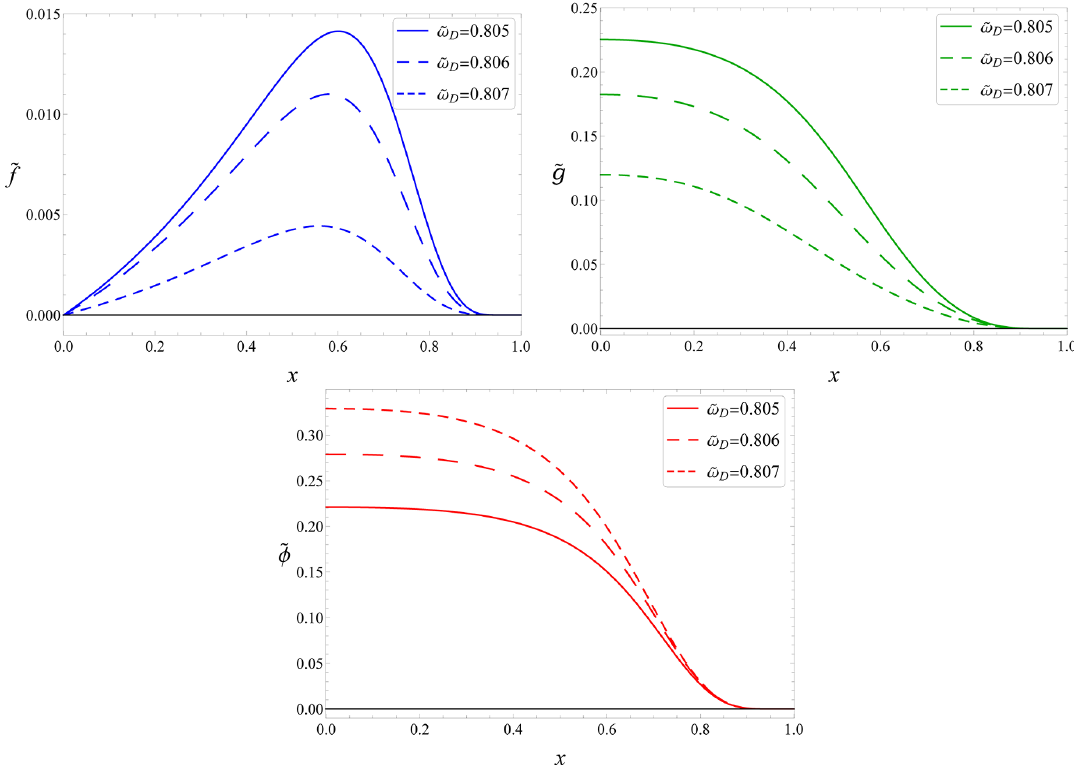
Figure 5. Dirac field functions ˜ f and ˜ g (top panels) and Scalar field function ˜ φ (bottom panel) as functions of x with ˜ ω D = 0 . 805 , 0 . 806 , 0 . 807 . All solutions have ˜ ω S = 0 . 79 and ˜ µ S = ˜ µ D = 1